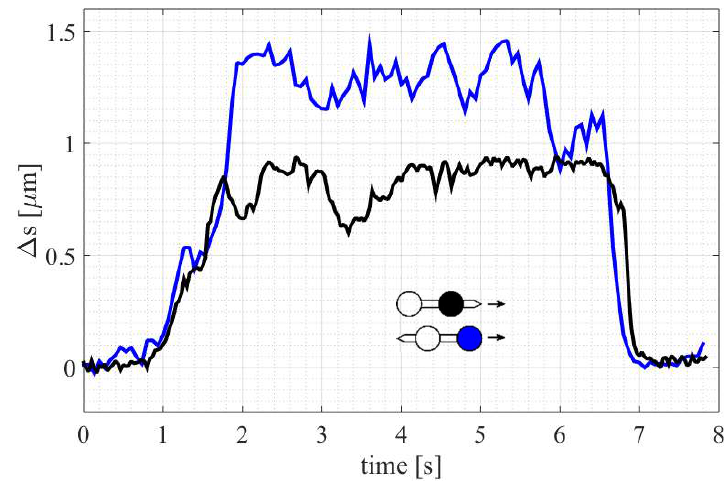
Figure 6. Drag force measurement for the micro-tool moving in two directions. Measured displacement of the front bead for the forward (black) and backward (blue) orientation of the tool. The tool velocity was increasing for the first 2 s, then kept constant and finally reduced to zero during the last 1.5 s.